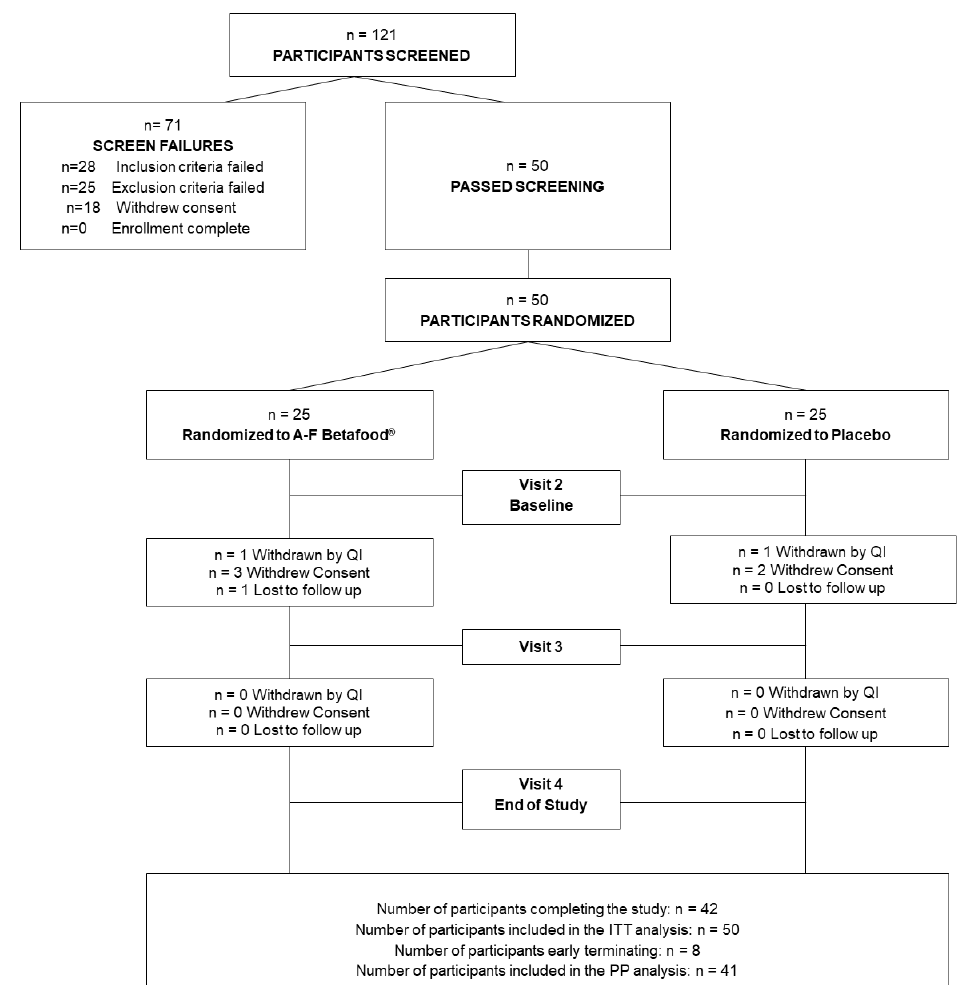
Figure 2. Participant disposition. Of the 121 participants screened, 50 eligible participants were enrolled and were randomized to receive either A-F Betafood ® or placebo at 25 participants per group. Eight participants, all early terminations, were not included in the PP population. “Withdrawn by QI” refers to a participant who is removed from the study by the Qualified Investigator for breach of the study protocol. “Withdrew consent” refers to a participant who withdraws themselves (or discontinues) from the study for personal reasons. ITT, intention to treat; PP, per protocol.